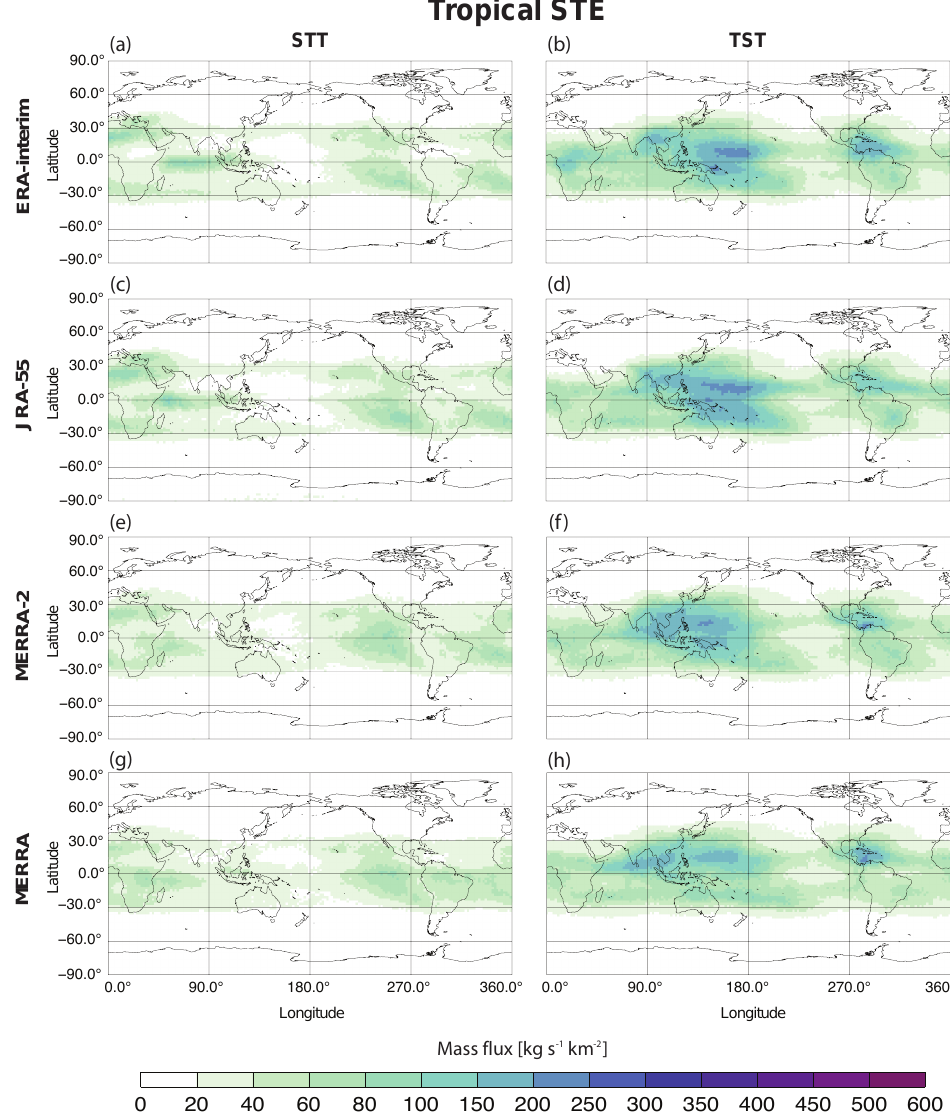
Figure 6. The same as in Fig. 4 but for the STE in the tropics.